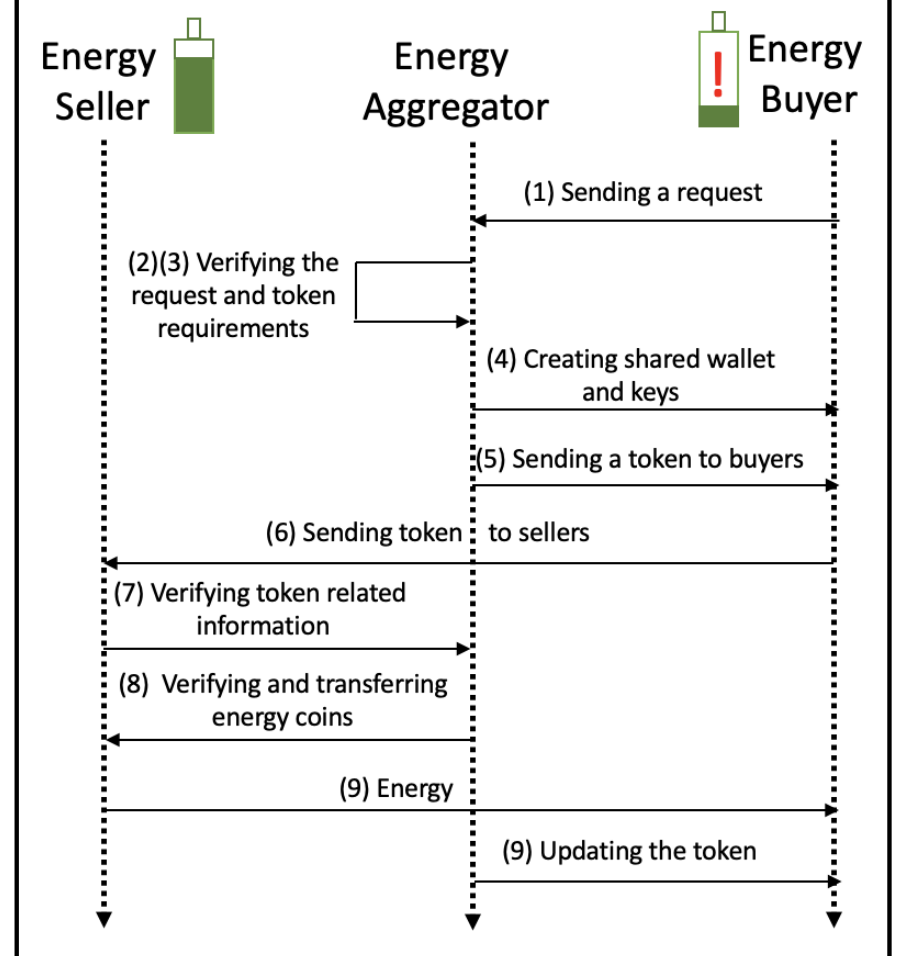
Figure 11. Main steps of credit-based payment